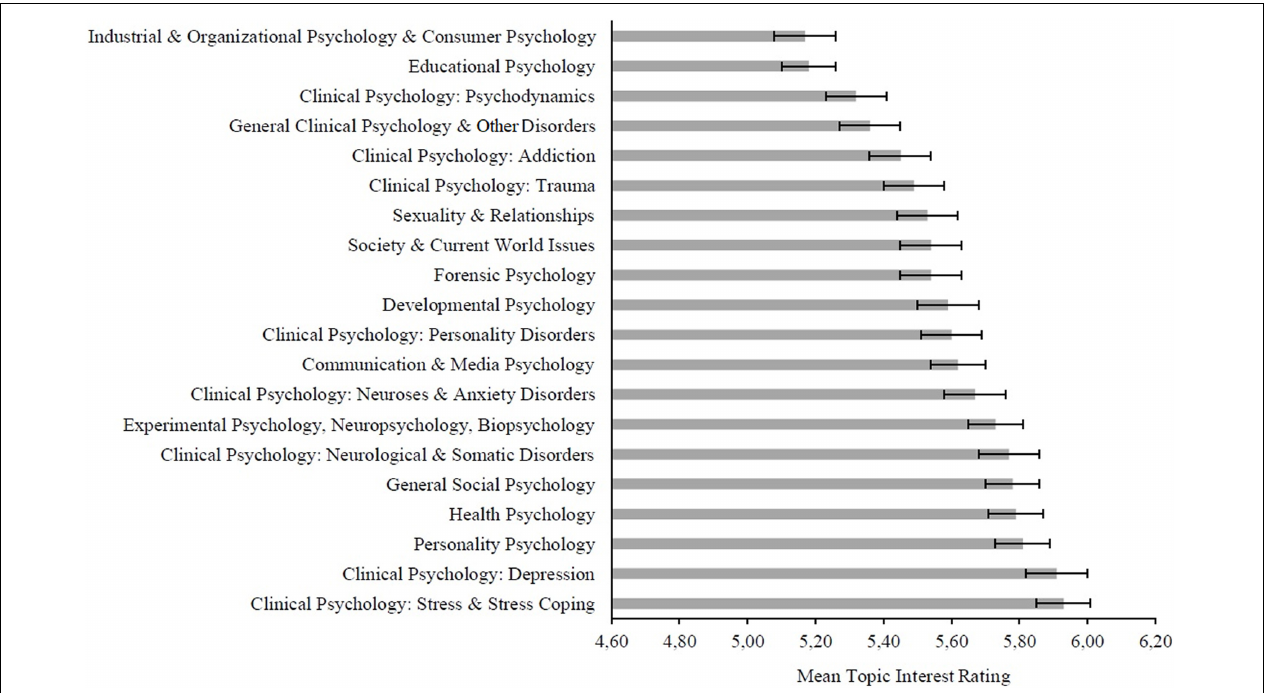
FIGURE 1 | Overview of the mean interest ratings of study I and II participants for all 20 topic categories with 95% confidence intervals (reproduced with permission from Benz et al.,